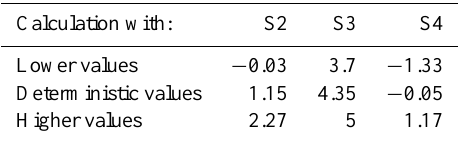
Table 6. Estimated ranges of “social sustainability” performance using a twenty-one-point